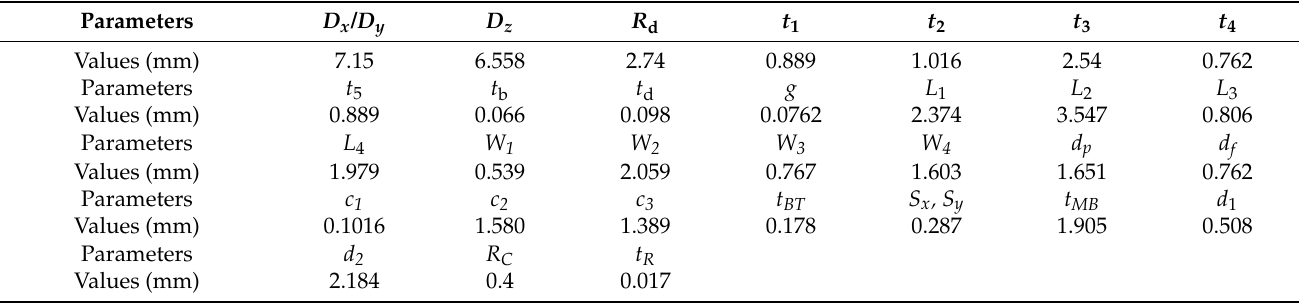
Table 1. PUMA Array Structure Parameters and Dimensions.